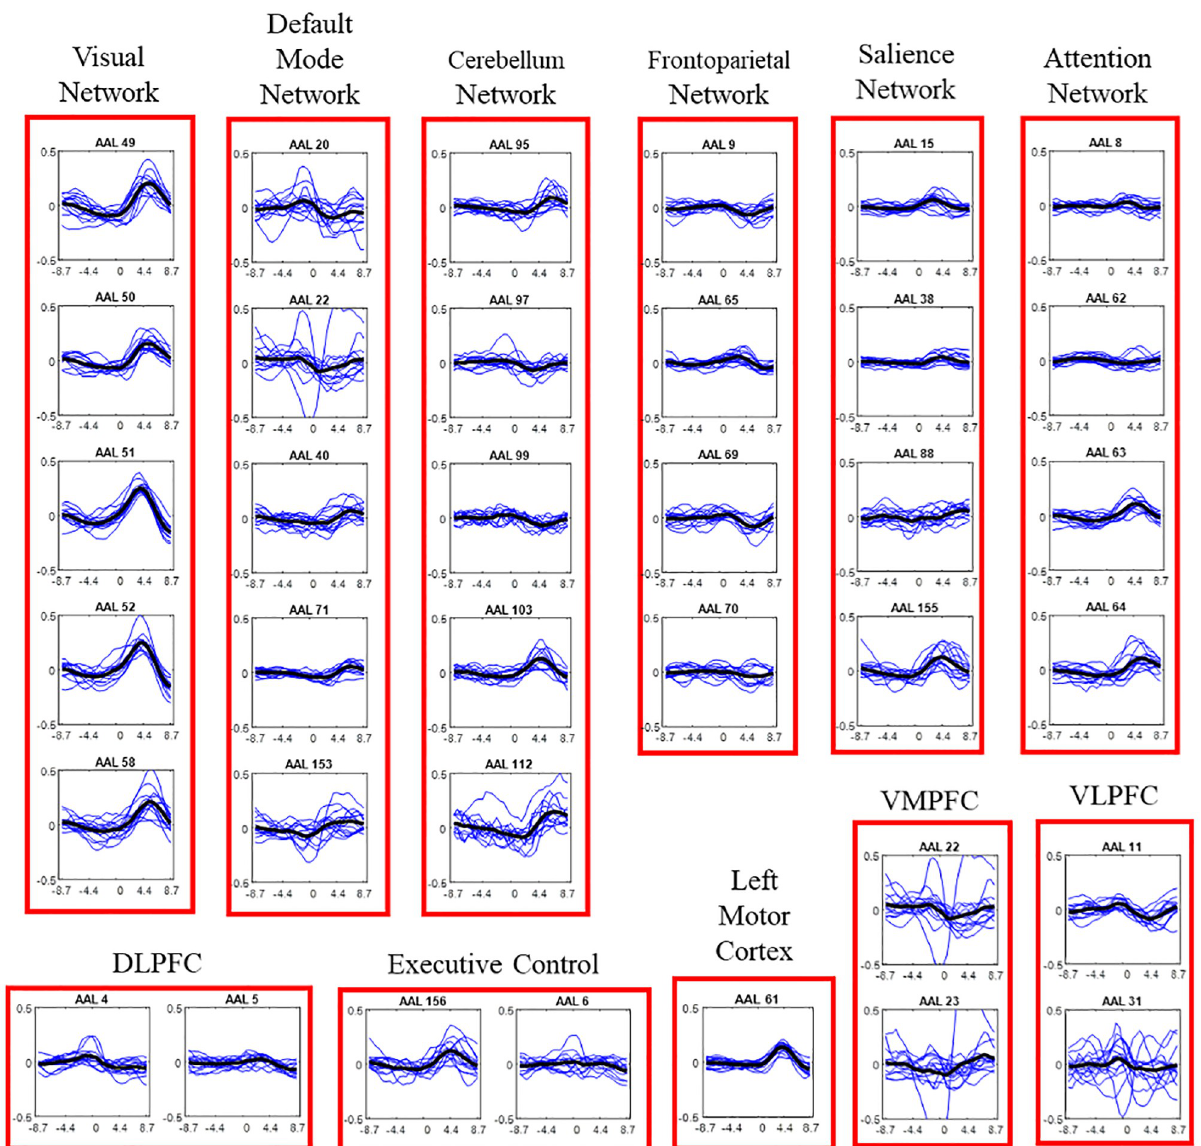
Fig 6. Temporal response plots for ROIs in different functional networks. The blue lines correspond to each subject’s response while the black line is the mean over all subjects. The x-axis represents time centered at the instance of button press, with the entire duration ranging from 10 seconds before to 10 seconds after the button press. The y-axis shows the percent signal change w.r.t the mean intensity value for particular